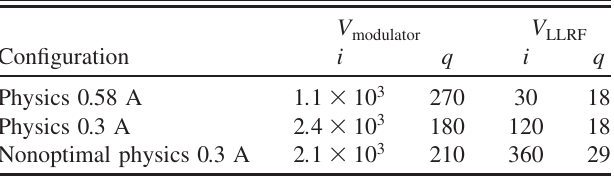
TABLE III. Modulator and LLRF noise threshold in n V = for physics configurations. These values correspond to the rf settings shown in Table